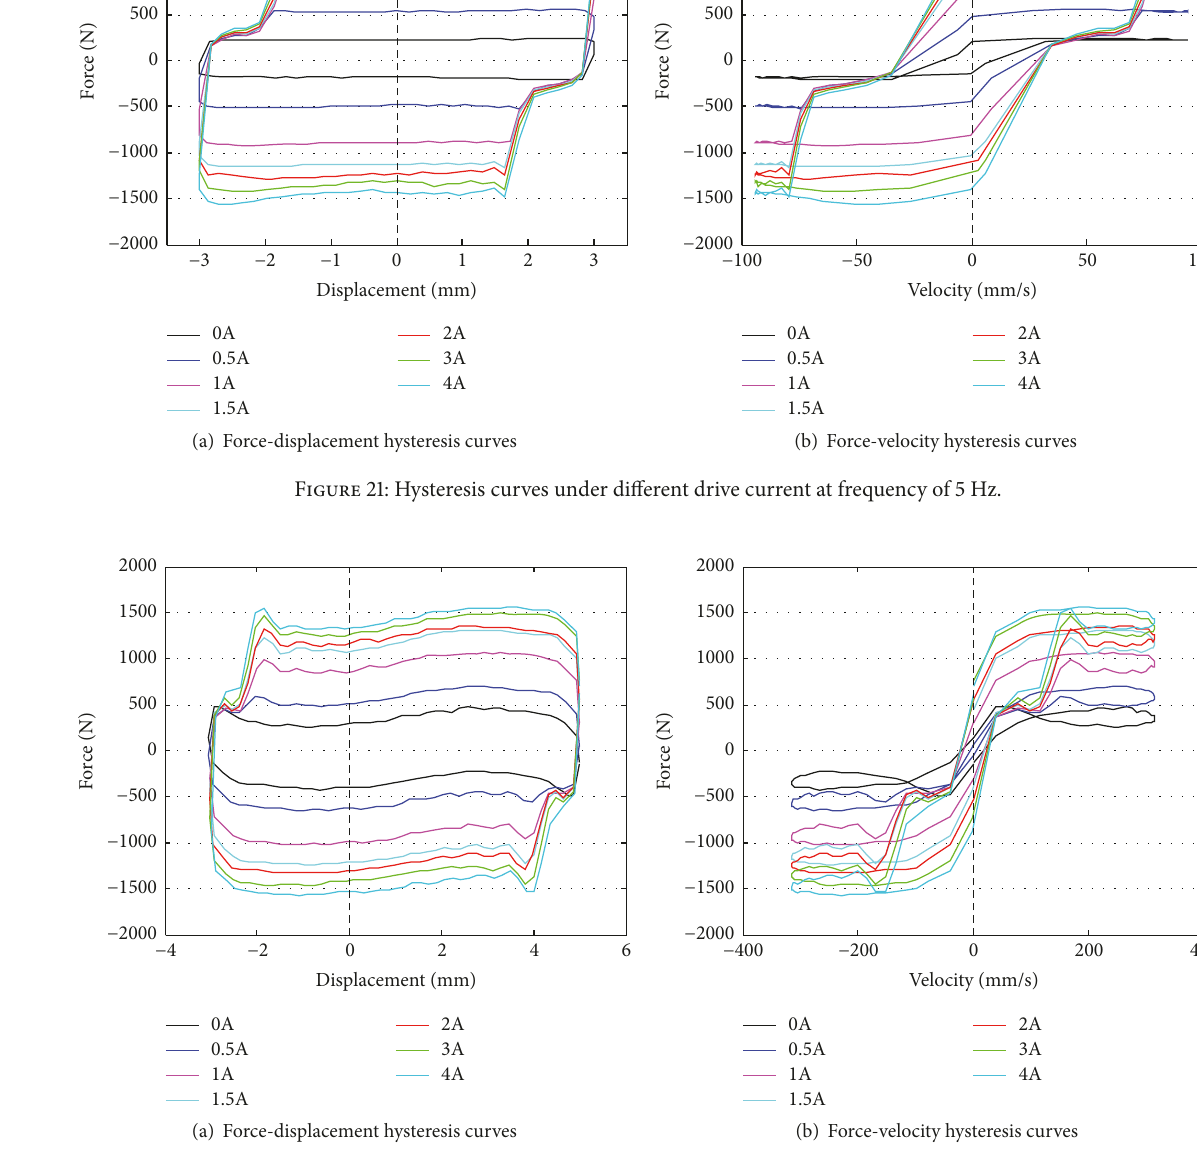
Figure 22: Hysteresis curves under different drive current at frequency of 10